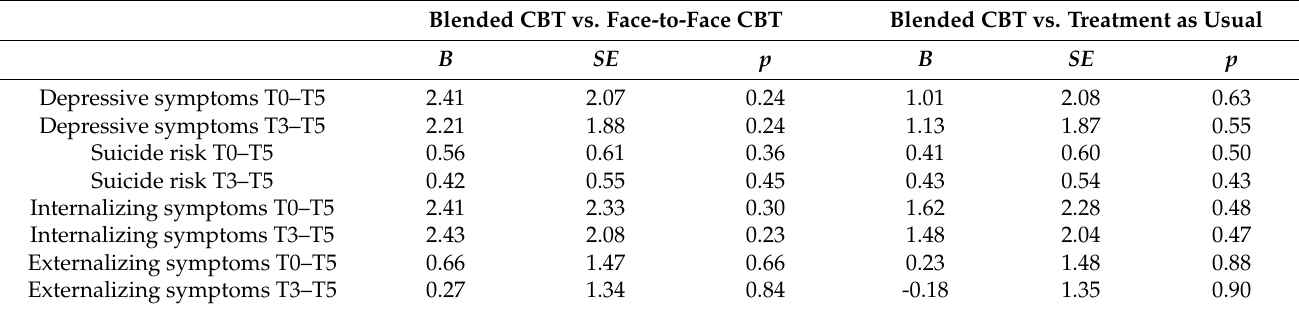
Table 2. Linear mixed model results of interaction terms between condition and time on depressive symptoms, suicide risk, internalizing symptoms and externalizing symptoms at 12-month follow-up